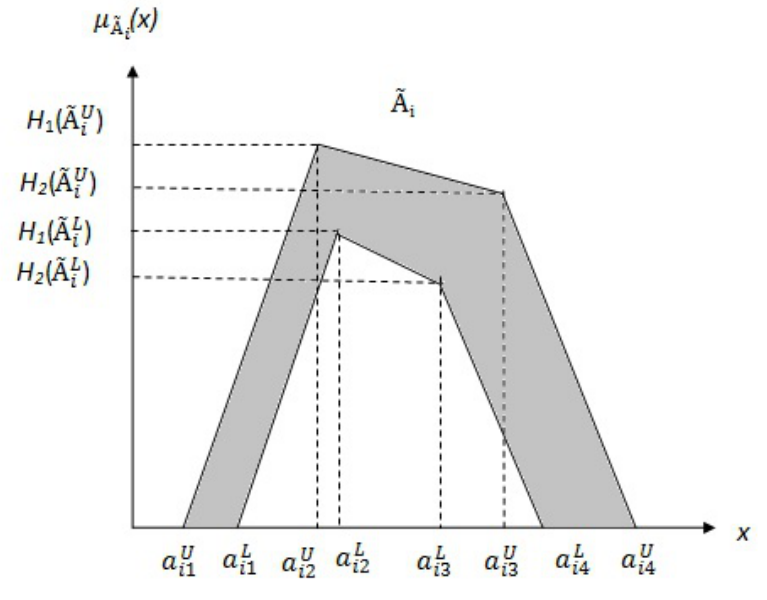
Figure 2. Reference points and their heights to determine a footprint of uncertainty (FOU) of IT2FS ˜ A i , where reference points UMF (cid:102) A trapezoidal LMF (cid:102) A